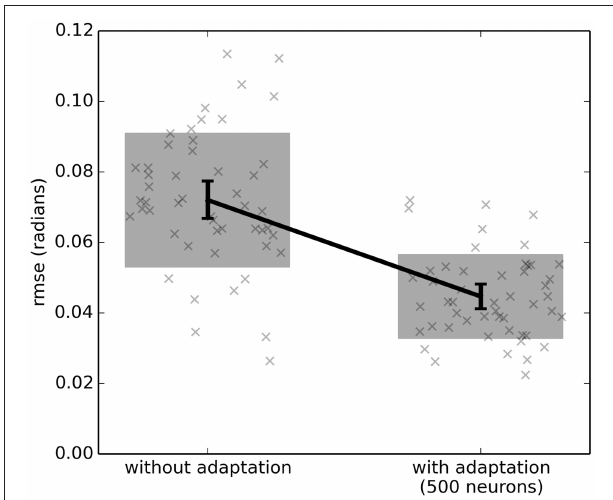
FIGURE 4 | The effect of adaptive control on a single-joint lego robot (Figure 2). Each run uses a randomly generated desired trajectory q d ( t ) over 20s, and root-mean-squared-error is computed over the last 10s only. The adaptive algorithm provides a significant improvement ( p < 0.05 ; two-tailed t -test; 50 samples). Scatterplots show individual runs (with random jitter on the x-axis to avoid overlap), the shaded area is the mean plus or minus the standard deviation, and the 95% confidence interval of the mean is